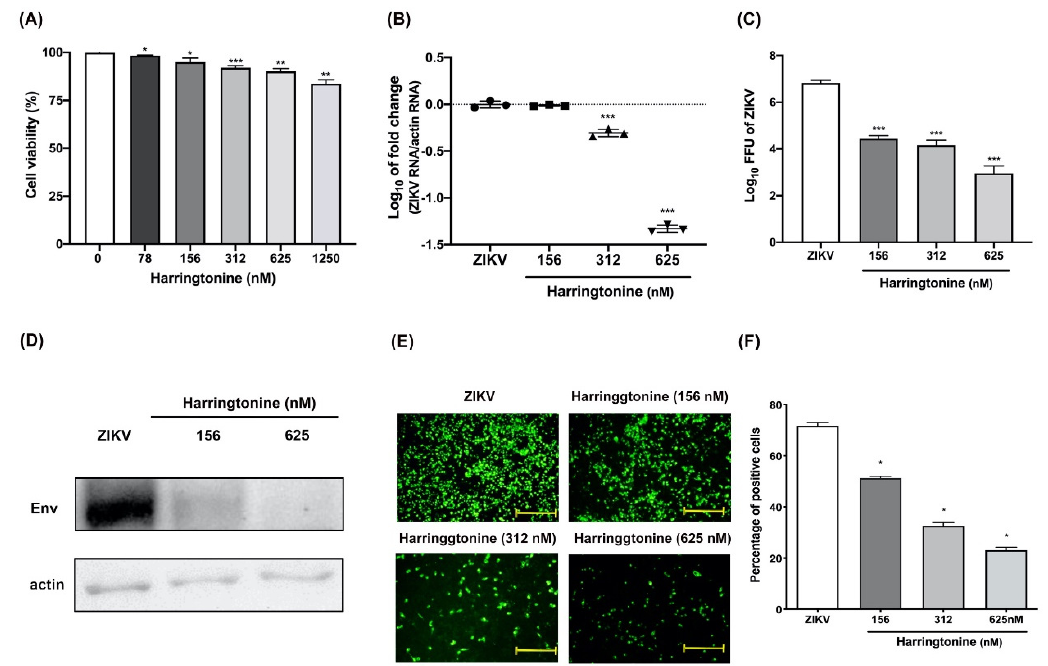
Figure 1. Antiviral activity of harringtonine against Mosquito-borne Zika virus (ZIKV). The cytotoxicity of harringtonine-treated Vero cells for 48 h was determined by Cell Counting Kit 8 (CCK-8) assays. The viability was determined with a Cell Counting Kit 8 assay. The experiments were carried out in triplicates, and the error bars represent standard deviation ( A ). Vero cells were infected with ZIKV and were treated with different concentrations of harringtonine for 48 h. The anti-ZIKV ability of harringtonine was analyzed by measuring viral RNA levels ( B ). The cell supernatants were harvested, and virus titers were assessed by fluorecent focus assay ( C ). The intracellular protein expression of Env was assessed by western blot ( D ). The severity of ZIKV infection was determined by IFA ( E ) and quantification of Vero cells ( F ). Statistical significance was analyzed from t -test compared with the ZIKV group: * p < 0.05; ** p < 0.01; *** p < 0.001. Scale bar: 50 μ m.